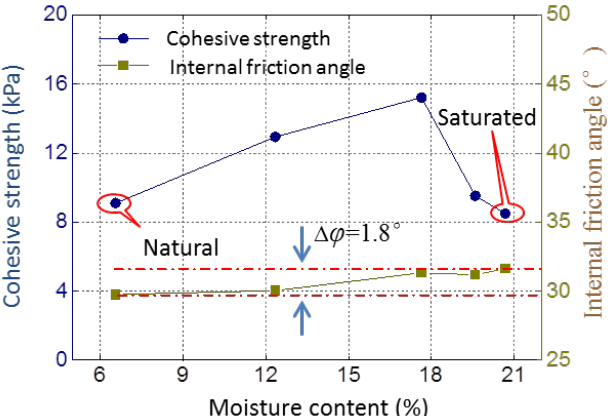
Figure 6. Effects of moisture content on cohesive strength and internal friction angle.